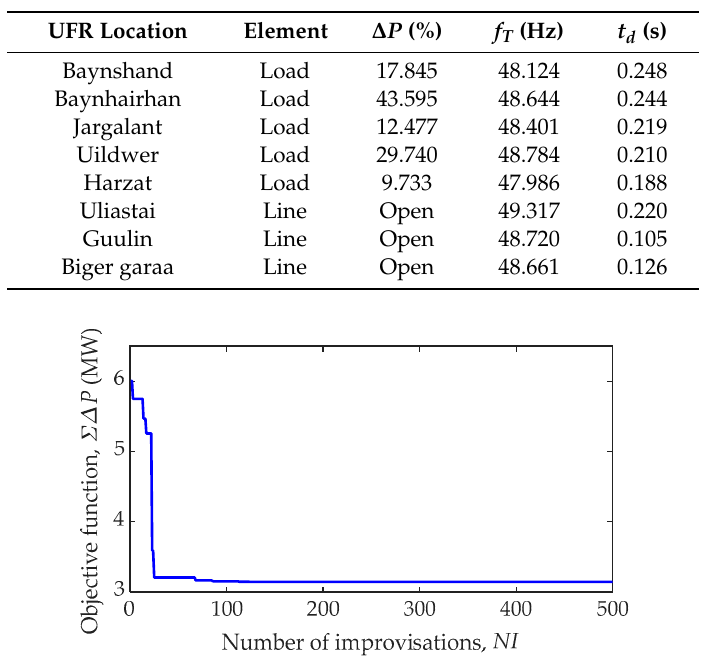
Figure 6. Convergence curve of optimal settings of UFRs for high inertia—summer season.